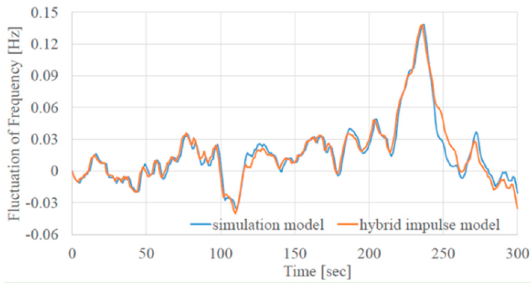
Figure 9. Hybrid-impulse response model performance.